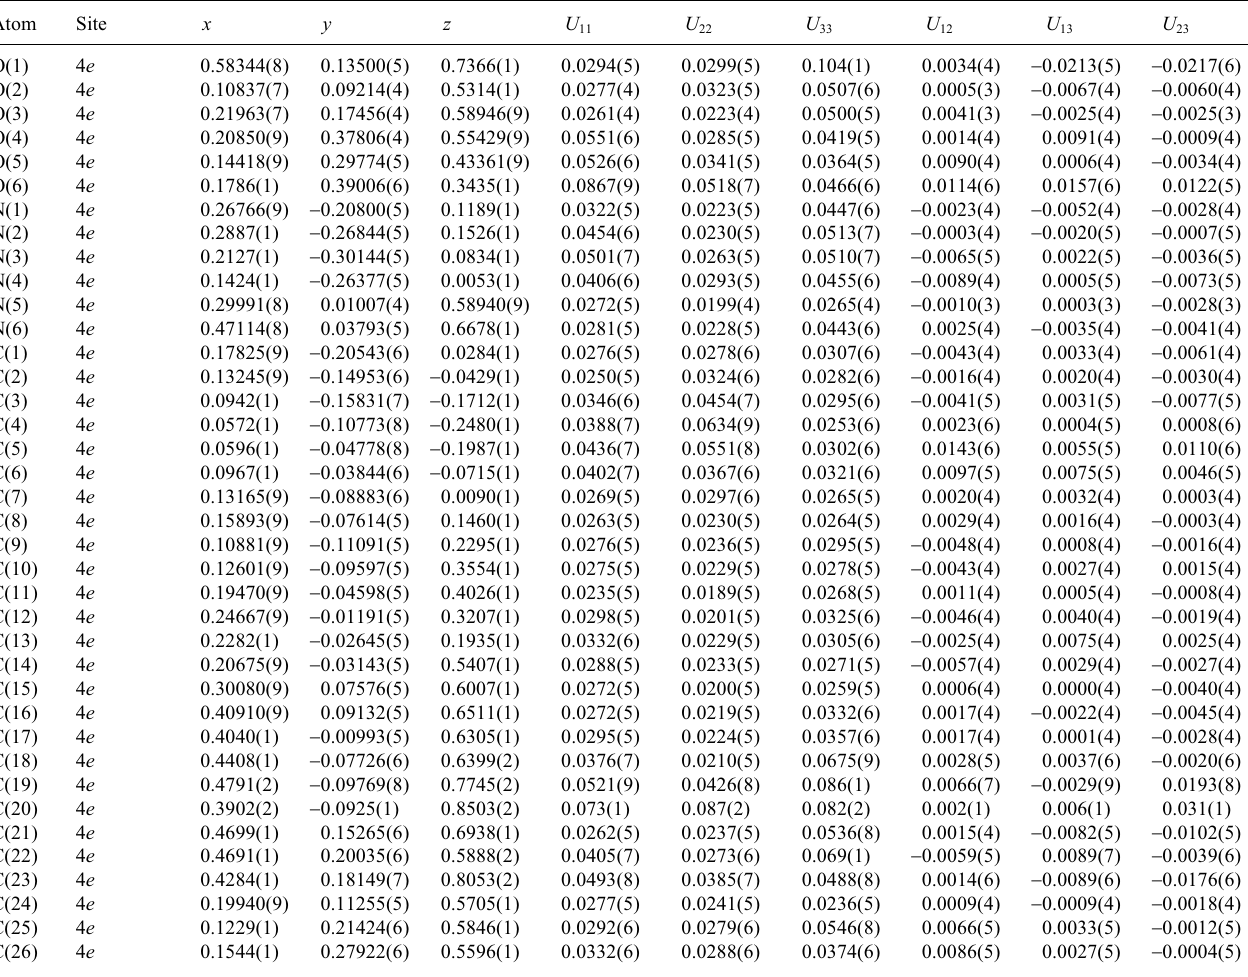
Table 3. Atomic coordinates and displacement parameters (in Å 2 )